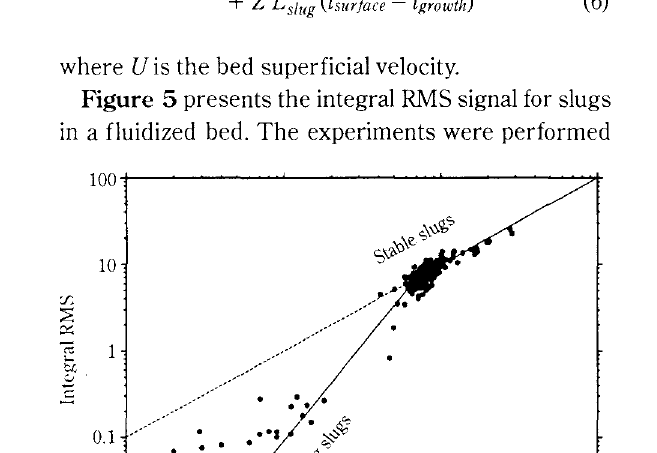
Audio signal dependence on time. Lines represent expected behaviors based on Eq.